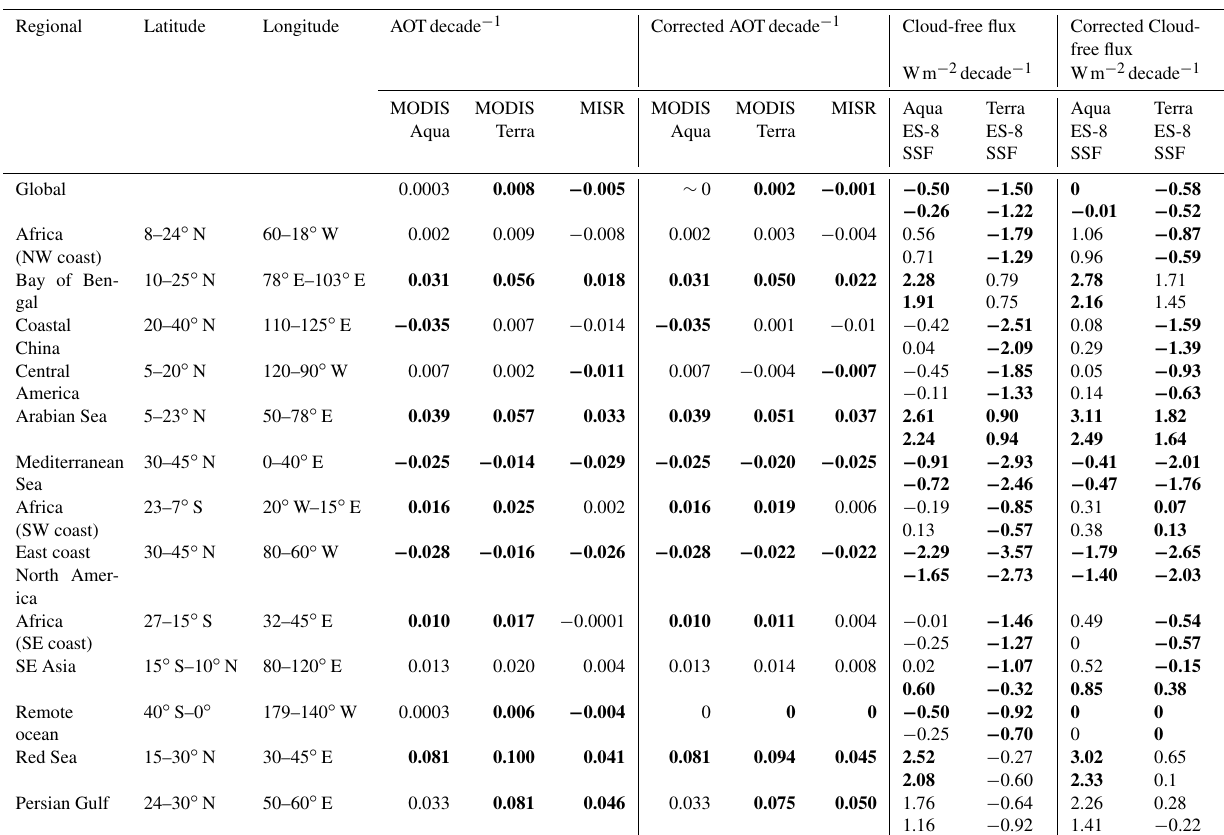
Table 3. Multiyear AOT and cloud-free flux trends (2002–2015 for MODIS Aqua; 2000–2015 for MODIS Terra; and 2000–2015 for MISR) for global and selected regions. AOT trends are calculated using monthly averaged, deseasonalized AOTs derived from the MODIS Collection 6 and MISR aerosol products. Cloud-free flux trends are calculated using seasonally averaged, deseasonalized cloud-free fluxes derived using the collocated MODIS–CERES SSF / ES-8 dataset. Various filtering criteria are applied to the data and described in the text. Trends that are statistically significant with a confidence interval of 95% (utilizing the Weatherhead method for monthly averages and the Mann–Kendall method for seasonal averages) are highlighted in